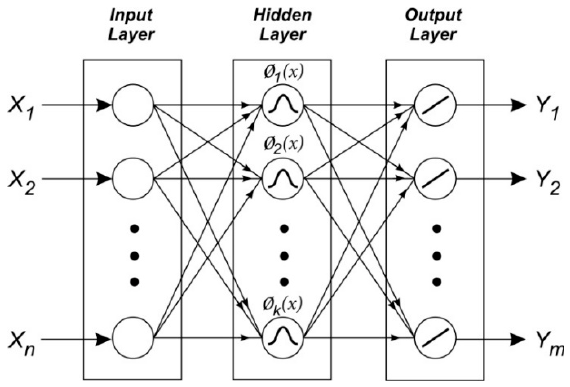
Figure 3. Structure of an RBF neural network.